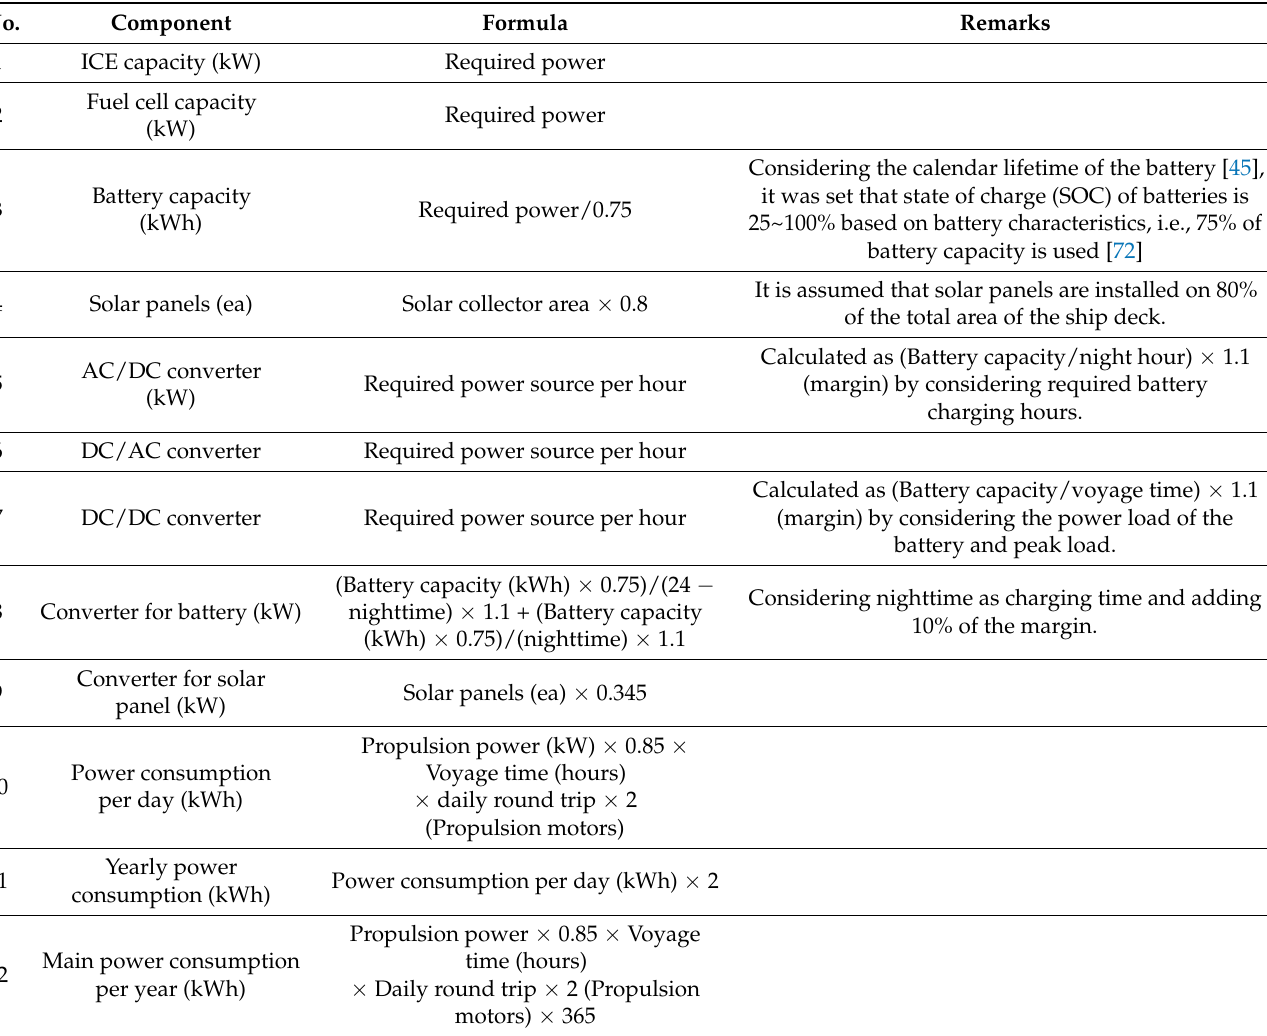
Table A2. Calculations for each component in this